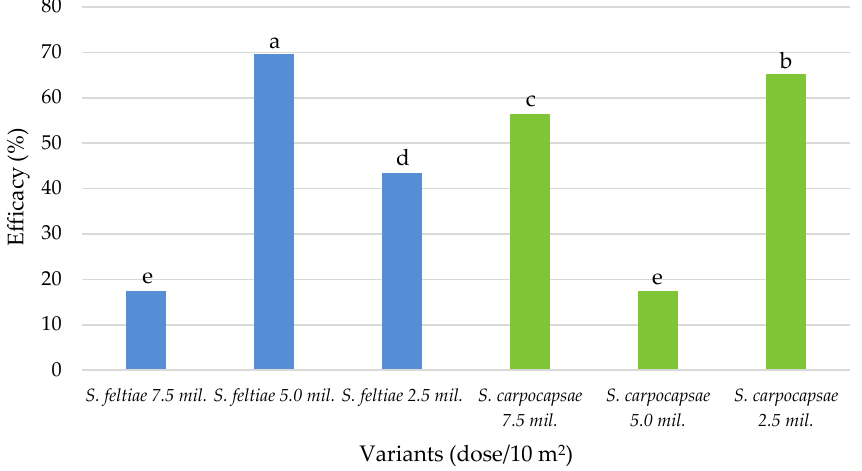
Figure 4. Average EPN efficacy on overwintered Colorado potato beetle populations in the 2019 field trial, Zagreb. Bars with different letters are significantly different ( p < 0.05, Duncan’s New MRT test).